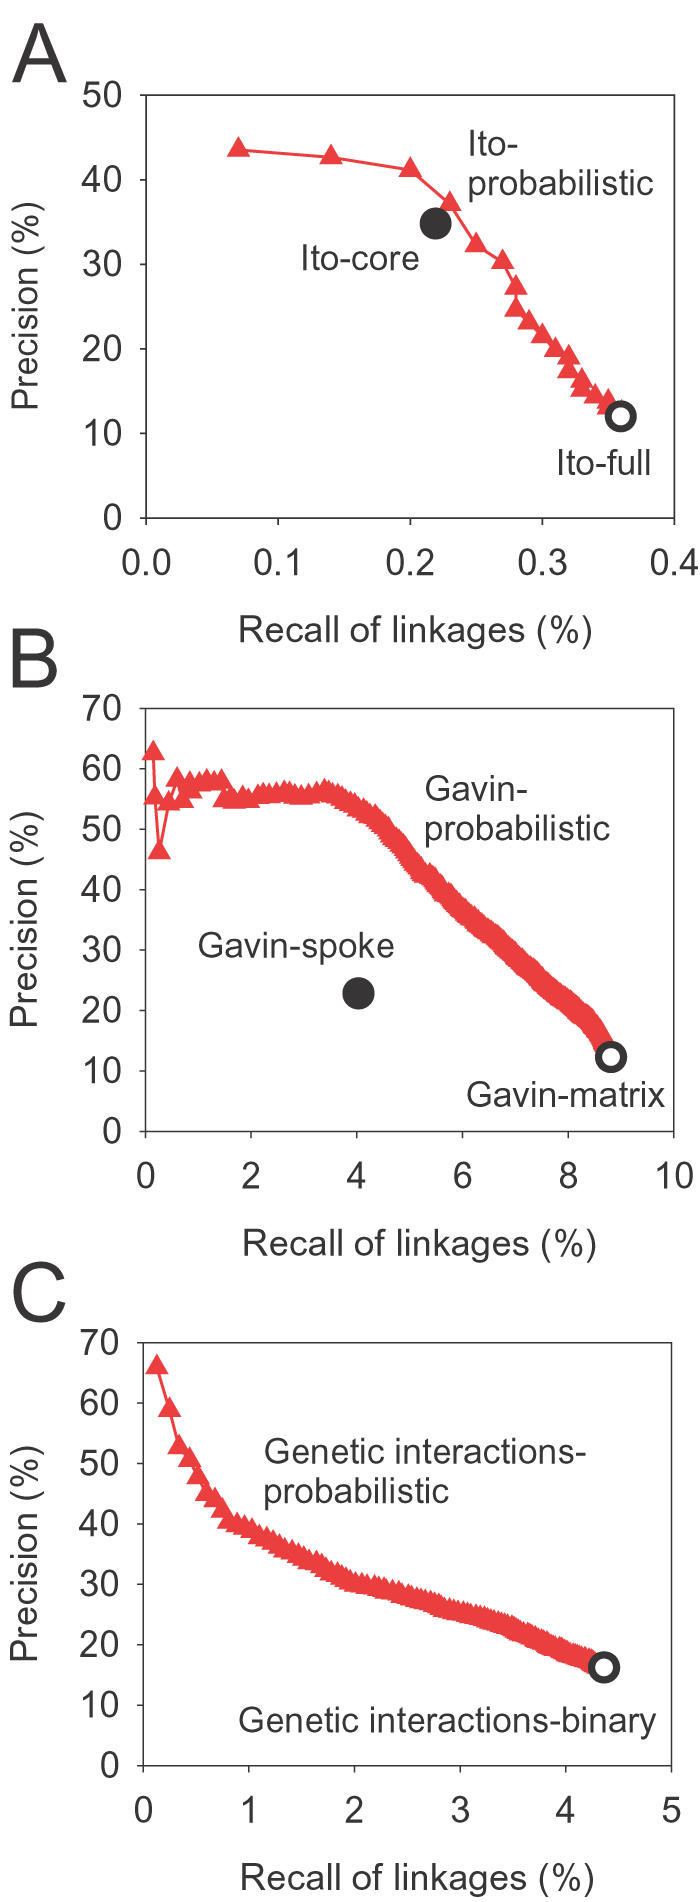
Assigning confidence scores to physical or genetic interactions.Performance of the hypergeometric probabilistic score is shown for gene functional associations inferred from (A) protein-protein physical interactions measured by the high-throughput yeast two hybrid (Y2H) screen of Ito et al. [20], (B) affinity-purified complexes identified by mass spectrometry by Gavin et al. [52], and (C) genetic interactions [43], [74]. Performance with the probability score is measured cumulatively for each successive bin of 200 interactions (A–C, red filled triangles), ranked by probability score. Recall and precision are calculated using the reference linkages derived from Gene Ontology “biological process” annotation masking the term “protein biosynthesis”. The Y2H core model described in [20] (A, filled circle) is more precise than the complete data set (A, open circle), but with reduced recall. Similarly, two different ways of inferring binary linkages from mass spectrometry-derived protein complexes [22]—the spoke (B, filled circle) and matrix models (B, open circle)—show differing trade-offs between precision and recall. The set of binary genetic interactions (C, open circle) shows very low precision for functional inferences, although the false positive rate of genetic interactions is generally perceived to be low; in contrast, the hypergeometric probability identifies a functionally informative subset of linkages. In general, the hypergeometric probability scores provide an excellent ranking of interactions in each of the data sets consistent with the linkages' functional informativeness.